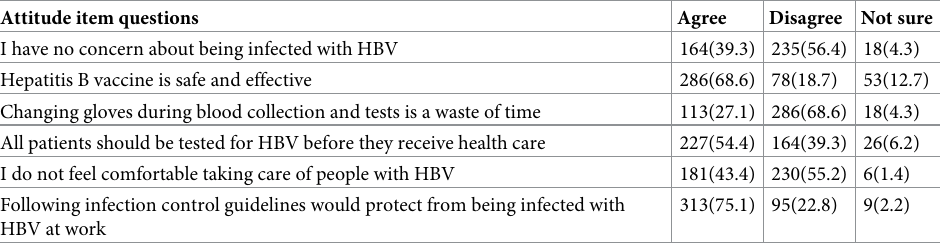
Table 3. Attitudes of study participants towards hepatitis B prevention at Wolkite University, 2020 (n = 417).